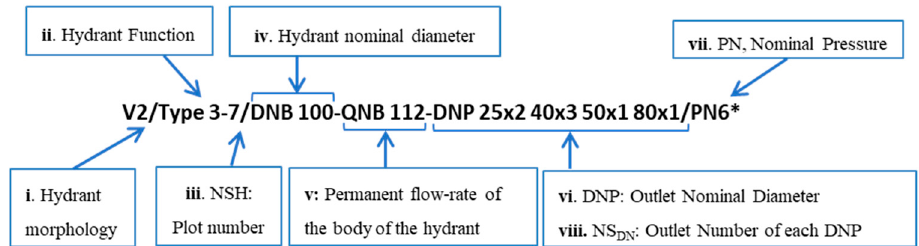
Figure 3. Locations of multioutlet hydrants identified in the field and tested in the laboratory. Data collection was carried out by running interviews with the WUAs’ managers.